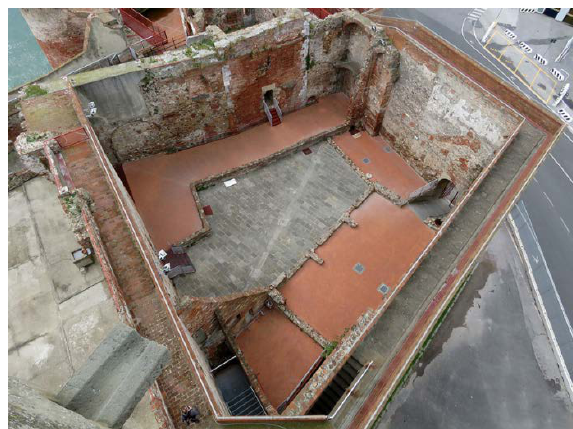
Figure 2: Quadratura dei